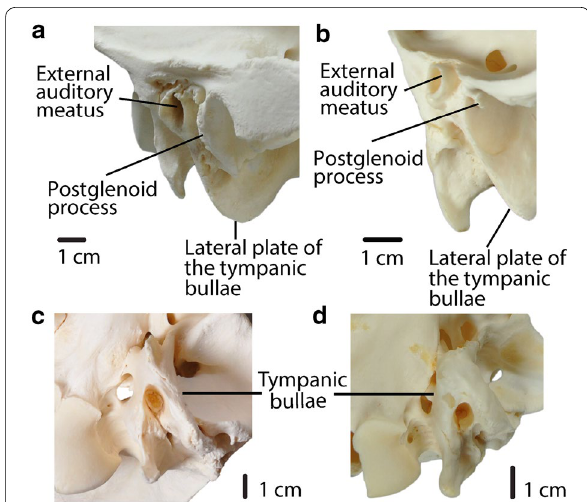
Fig. 8 a , b : Char. 35: “Postglenoid process and postglenoid foramen”. a C. bactrianus (ZM 17,970), right side, scored large (1). b L. guanicoe (ZM 17,209), left side, scored small‑to‑absent (0). a , b : Char. 38: “Position of the lateral plate of the bullae in lateral view”. a C. bactrianus (ZM 17,970), right side, scored below external auditory meatus (0). b L. guanicoe (ZM 17,209), left side, scored anterior to external auditory meatus (1). c , d : Char. 37: “Tympanic bullae”. c C. bactrianus (ZM 17,970), ventral view, scored little inflated (1). d L. guanicoe (ZM 17,209), ventral view, scored greatly inflated